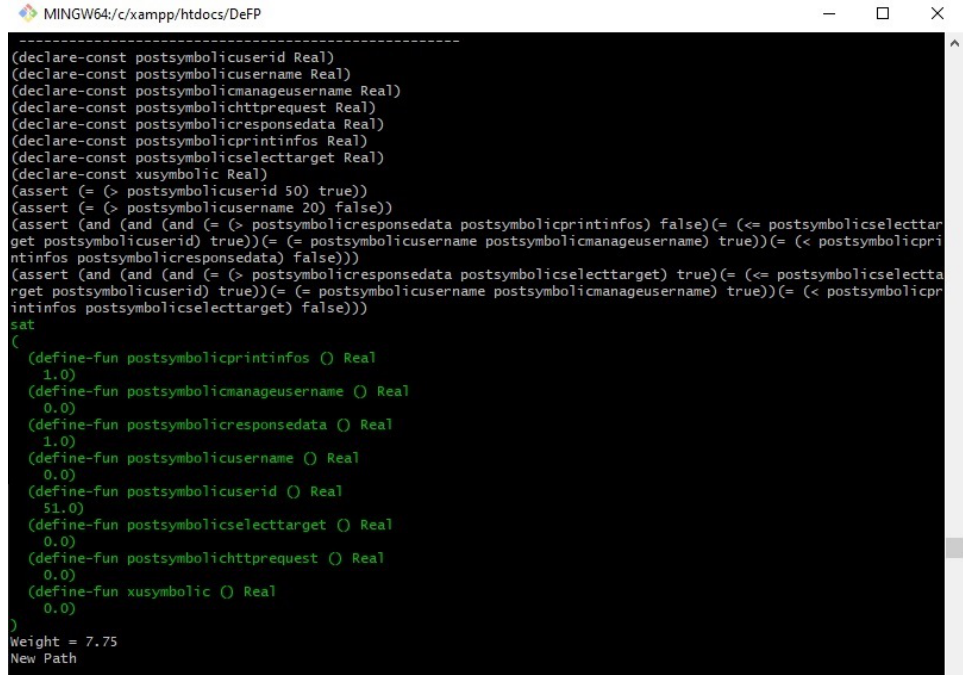
Figure A1. Example of feasible path detected in Peruggia